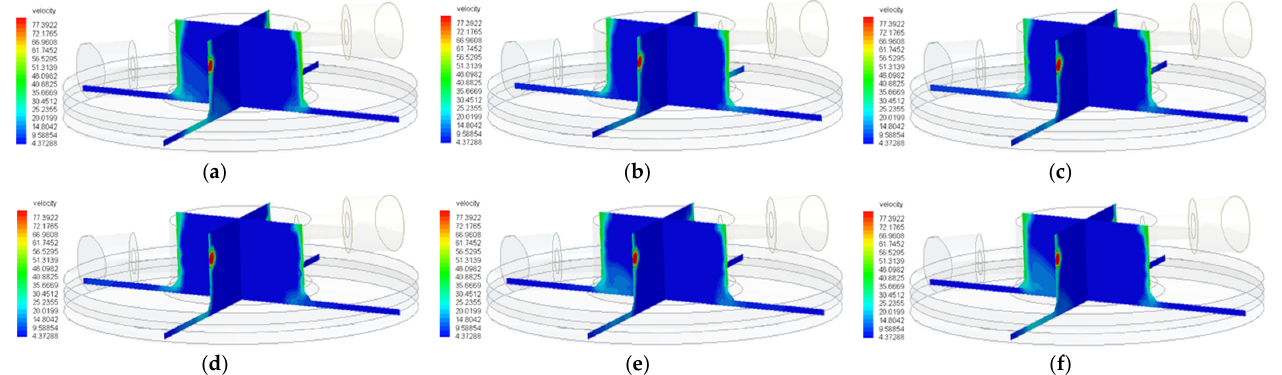
ms, ( e ) 22.6 ms, the ( f ) 27 ms.